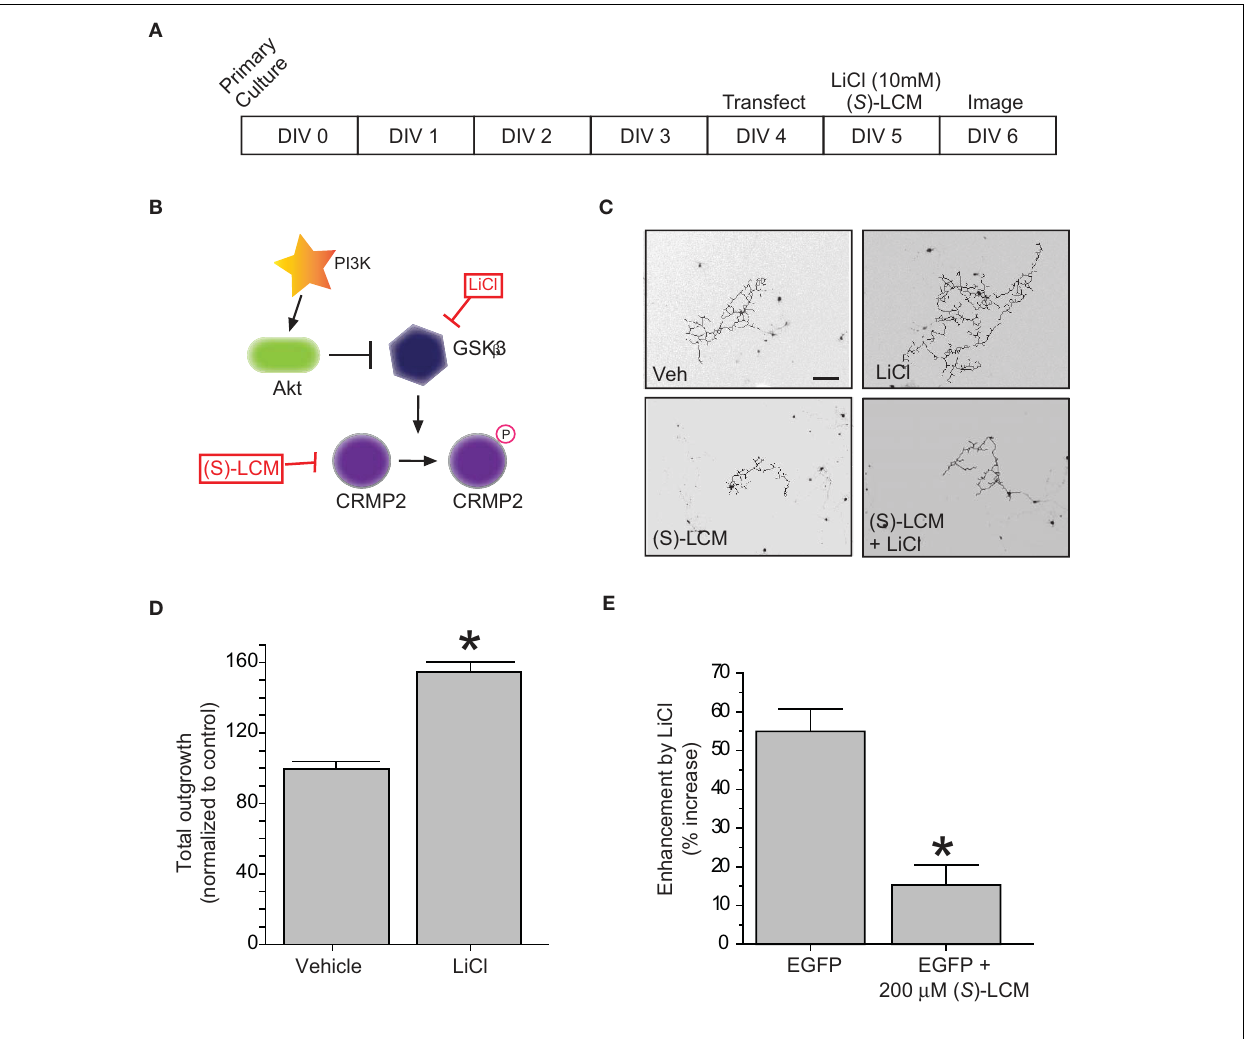
FIGURE 2 | Inactivation of GSK3 β enhances neurite outgrowth in a CRMP2-dependent manner. (A) Experimental timeline. Cortical neurons were transfected with EGFP at 4DIV and exposed to vehicle ( < 0.01% DMSO), LiCl (10mM), ( S )-LCM (200 μ M), or LiCl + ( S )-LCM for 24h starting at 5DIV and imaged at 6DIV. (B) GSK3 β signaling cascade. (C) Representative tracings of neurons transfected with EGFP and exposed to